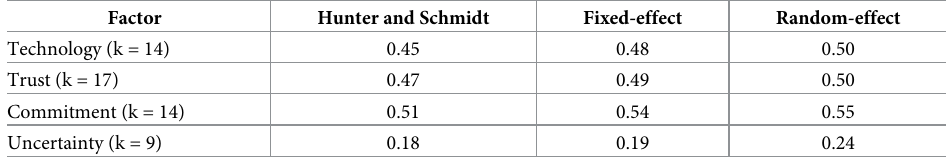
Table 4. Correlation coefficient between factors and information